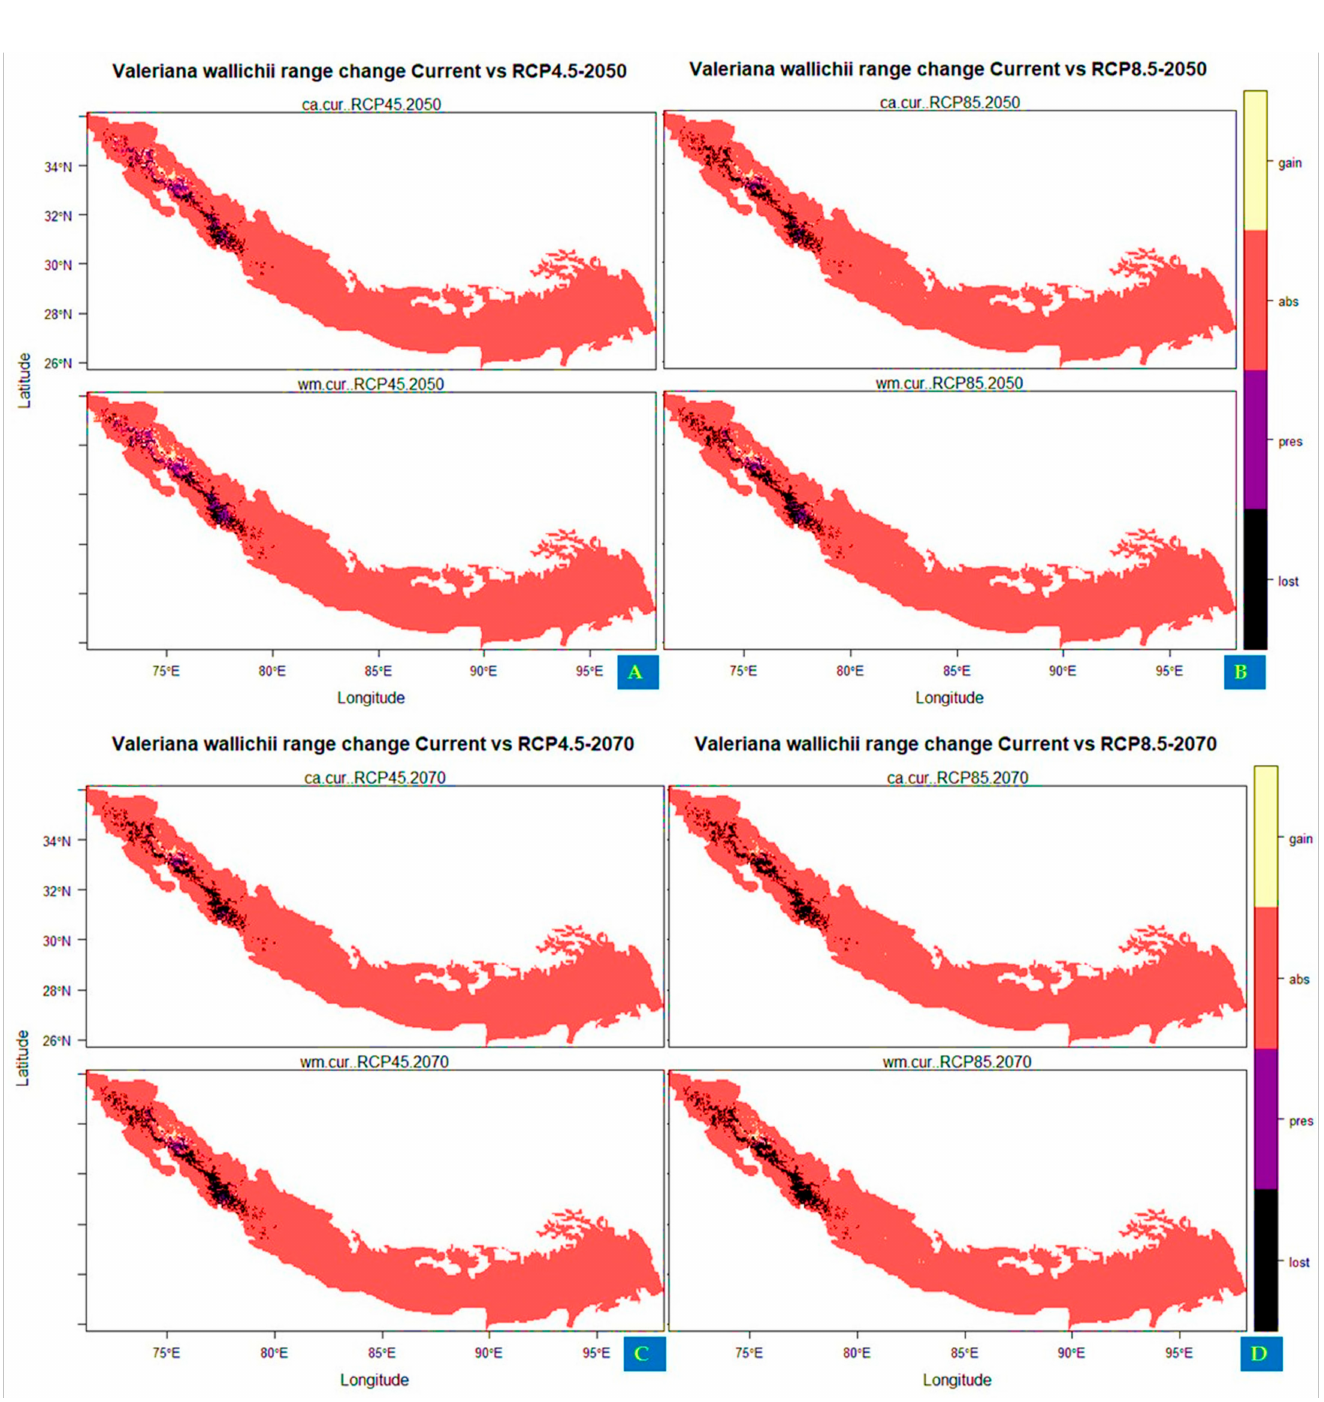
Figure 4. Distribution maps showing range change area of Valeriana wallichii under future climatic scenarios ( A , B ): under representative concentration pathway 4.5 and 8.5 for year 2050 ( C , D ): under RCP 4.5 and 8.5 for year 2070. Olive color in the scale represents the areas where newly suitable areas appear in the future climate scenarios, black color represents the areas where the habitat suitability is lost in the future, purple color represents the regions that maintain the habitat suitability in the future climatic conditions, and red color shows the regions where the species is